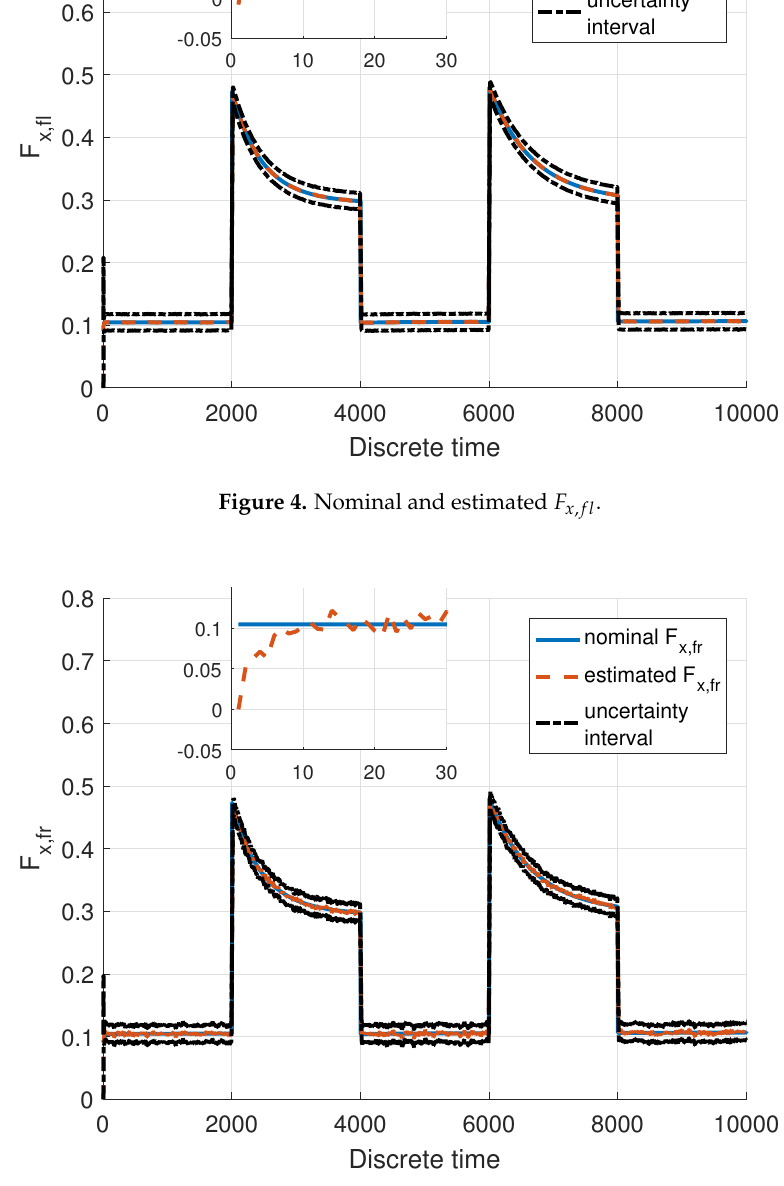
Figure 5. Nominal and estimated F x , fr